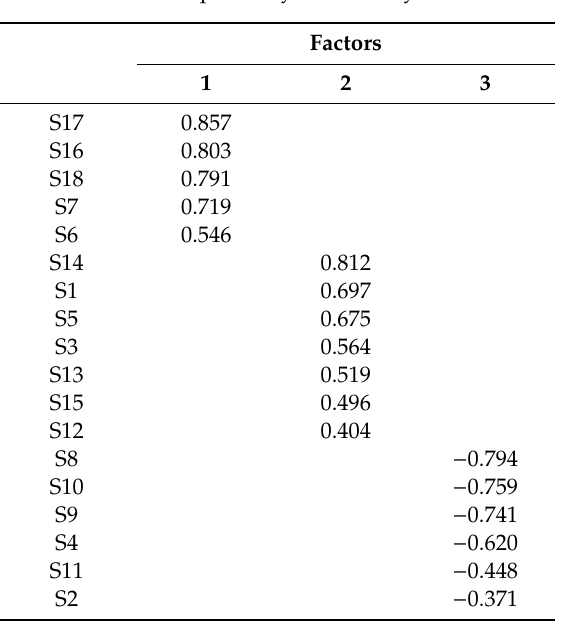
Table 2. Exploratory factor analysis a